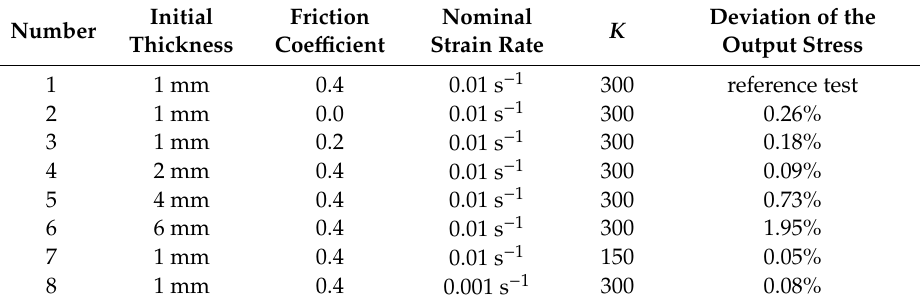
Table 1. The conditions of the tests and the deviations in output stress reflecting the variation of specimen thickness, friction coe ffi cient, nominal strain rate, and the value of K